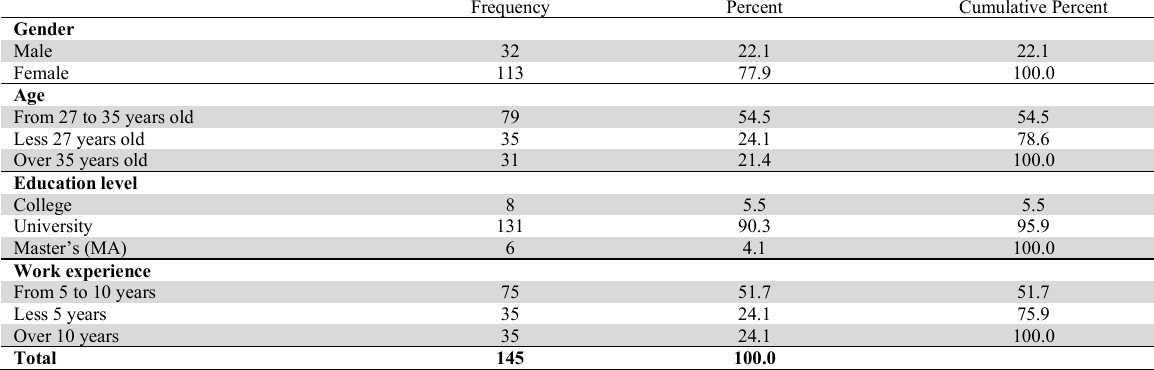
Respondents by gender, age, education level and work experience